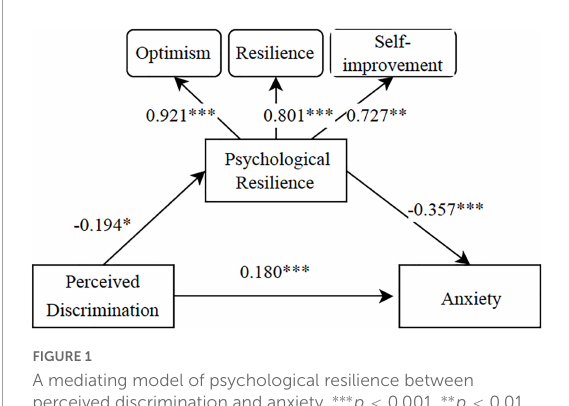
FIGURE1 A mediating model of psychological resilience between perceived discrimination and anxiety. ∗∗∗ p < 0.001, ∗∗ p < 0.01, ∗ p <